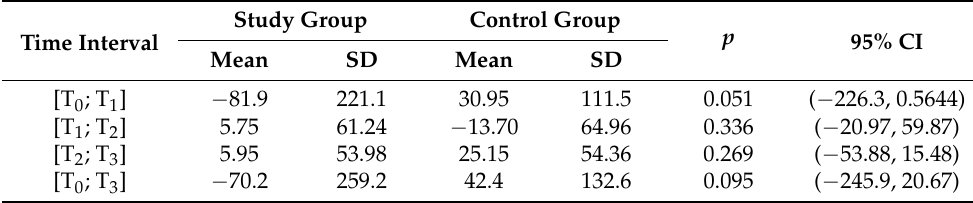
Table 5. Comparison of SAT changes. Mean and SD in